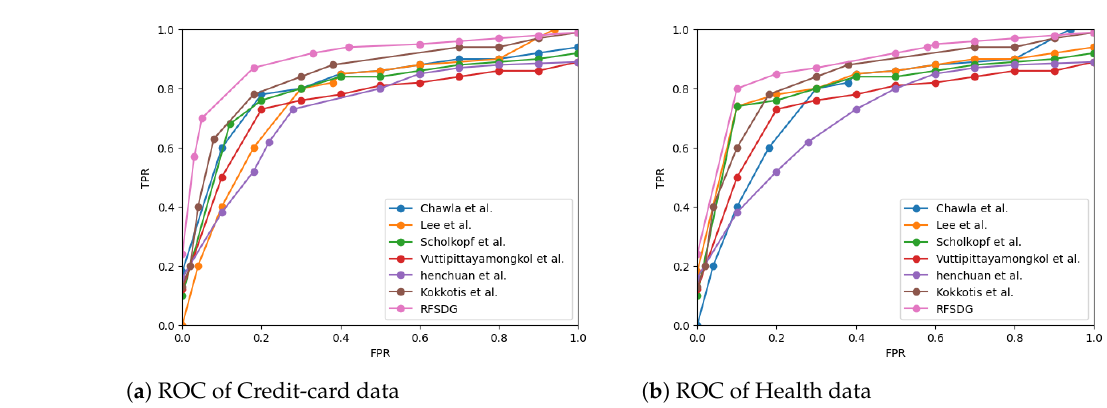
Figure 2. Comparison of the performance of different methods.